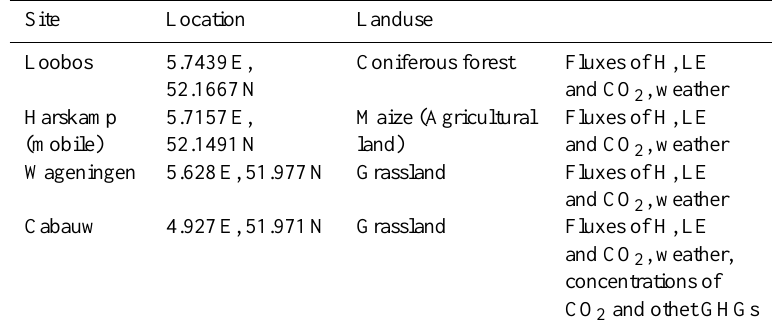
Table 3. Description of observational sites during the RECAB